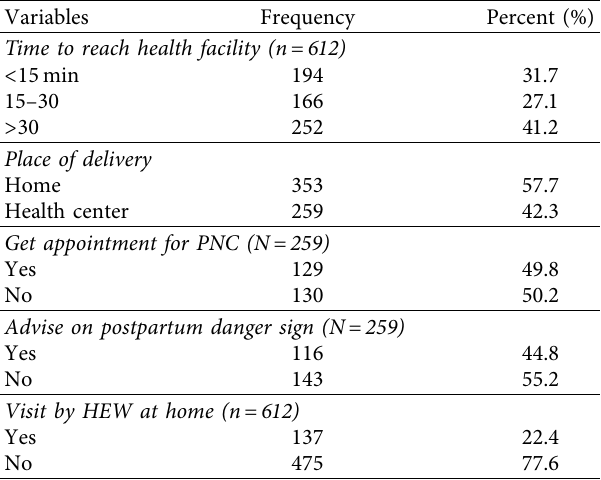
Table 4: Health service-related factors of respondents among mothers who gave birth in that last six months at Wonago District, South Ethiopia,